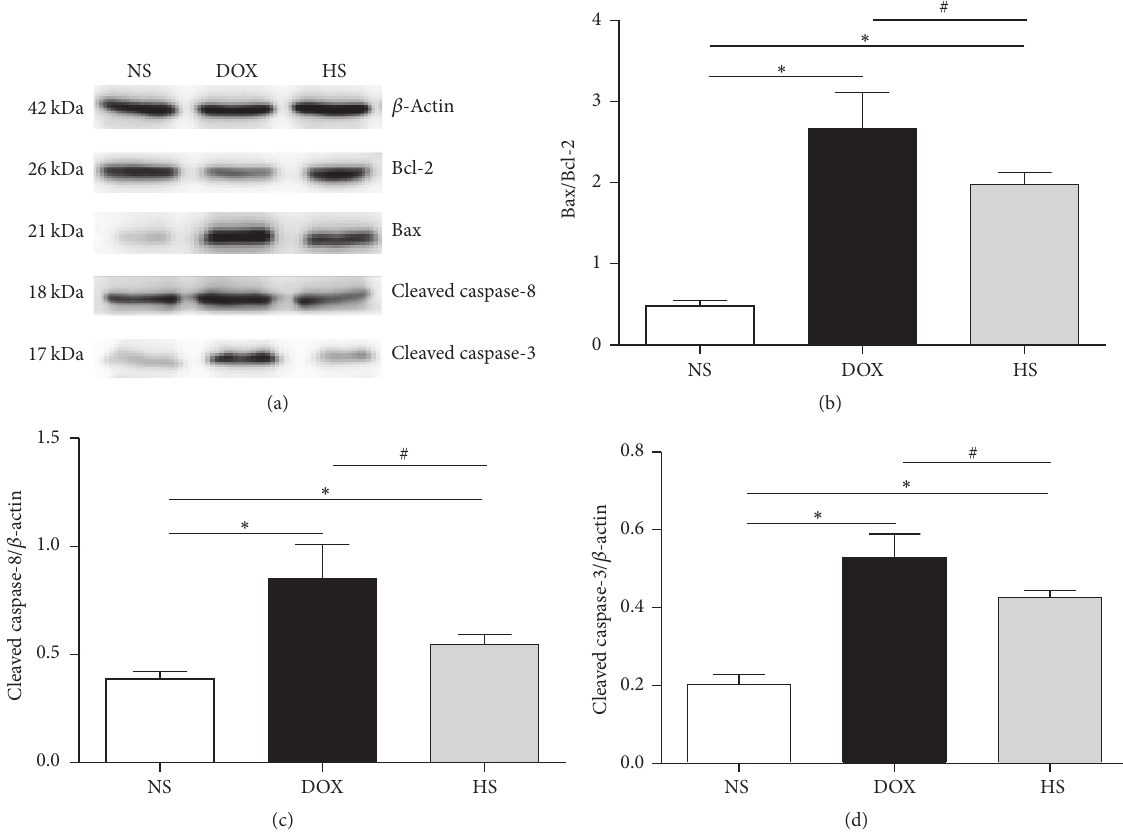
Figure 8: The antiapoptosis effect of hydrogen-rich saline on hepatic tissue. Representative expression of apoptosis-related proteins in the liver of three groups was detected (a–d). Data are shown as mean ± SD, 𝑛 ≥ 3 . ∗ 𝑃 < 0.05 versus NS group; # 𝑃 < 0.05 versus DOX